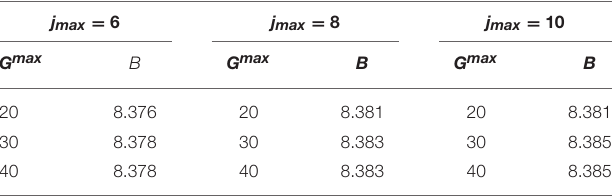
TABLE 3 | Same as Table 2 but for the Minnesota potential model [15].